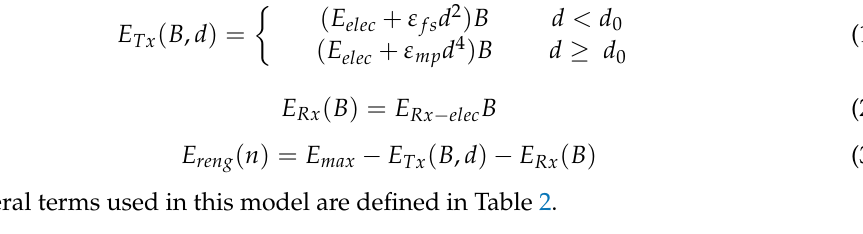
Table 2. Definition of terms used in the energy